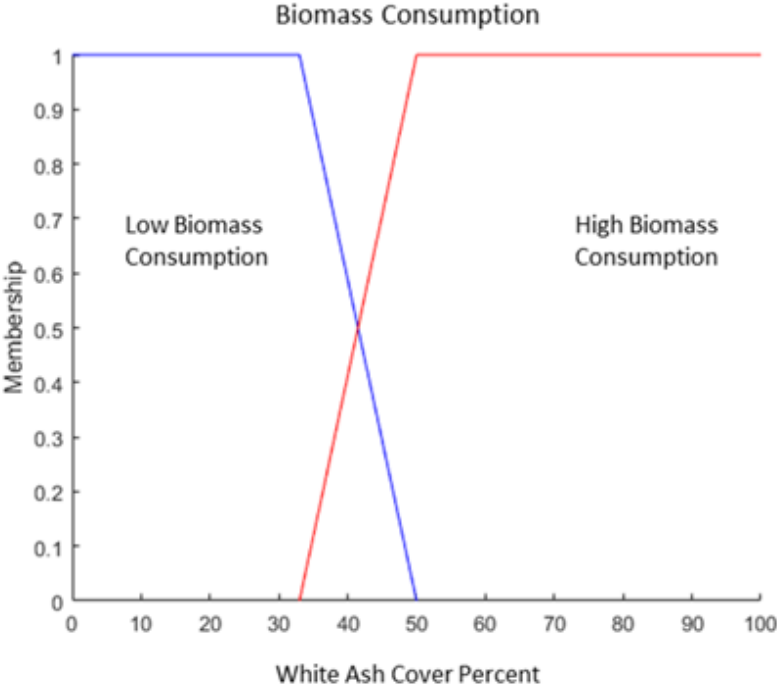
Figure 4. Biomass Consumption fuzzy set showing fuzzy set membership of 30 m pixel transition between Low and High Biomass Consumption from 33 to 50 percent of 5 cm burned pixels being classified as white ash.